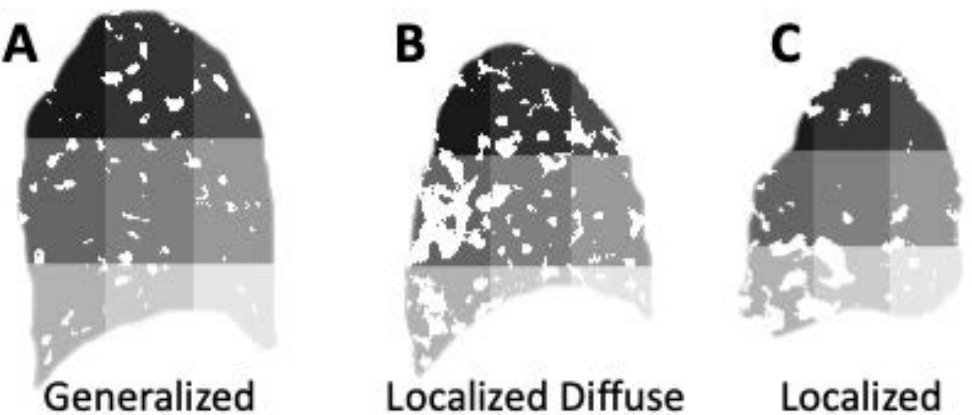
Figure 10. Samples of excess fluid spatial presentation groups. ( A ) is a generalized spatial presenta- tion, ( B ) is a localized diffuse spatial presentation, and ( C ) is a localized spatial presentation. Image masks are shown where each ROI is identified by a different shade of grey. Excess fluid is shown in